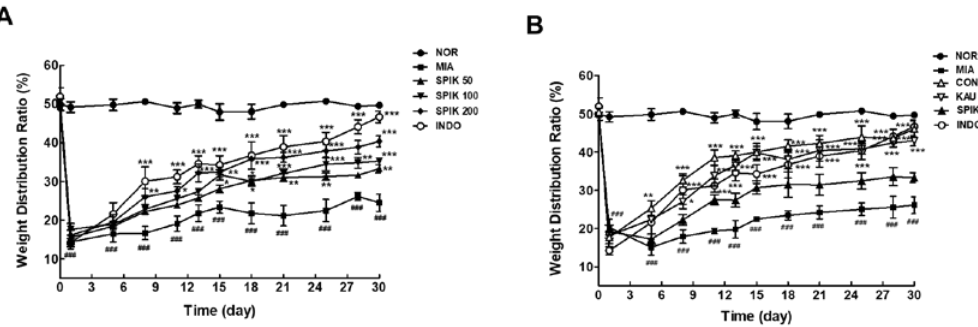
Figure 5. Behavioral assessments, indicated by weight distribution ratio of the per cent of weight carried on each hind leg, of anti − arthritic activities of the 50% ethanolic extract of Manchurian spikenard ( A ), and its chemical compounds such as continantalic and kaurenoic acids ( B ) in the monoiodoacetate (MIA) − induced monoarthritic rats. The spikenard extract was i.p. injected in Figure B being contrast with oral administration in Figure A. SPIK, Manchurian spikenard extract; CONTI, continentalic acid; KAU, kaurenoic acid; INDO, indomethacin. ### p < 0.001 vs. non-treated normal group (NOR); * p < 0.05, ** p < 0.01, *** p < 0.001 vs. vehicle-treated MIA group without SPIK, CONTI or KAU treatment.